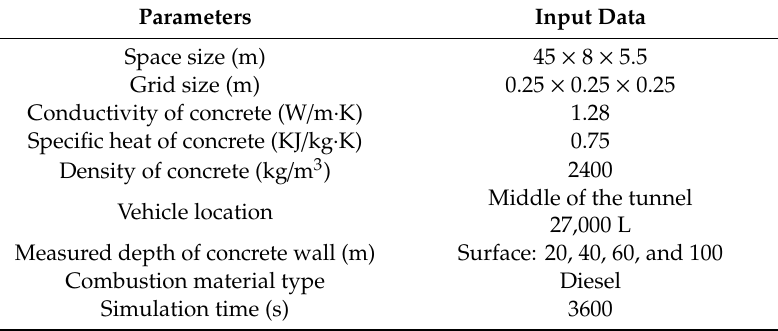
Table 3. Vehicle fire analysis conditions.